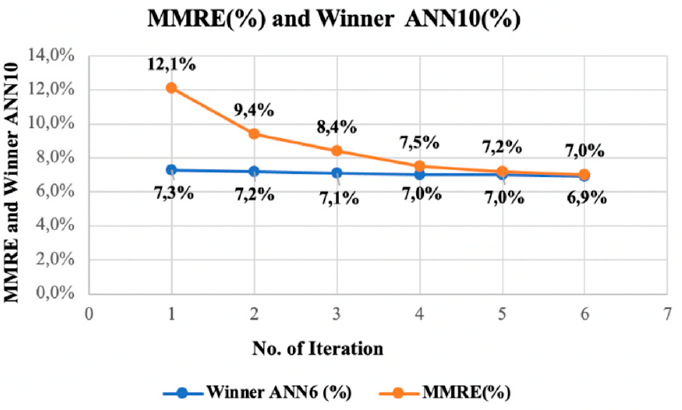
Figure 7. GA for ANN-L36prim-training part (UCP). A graphical representation of the MRE value for the Winner network, relative to the MMRE value on the training dataset, during six iterations, is given in Figure 8.